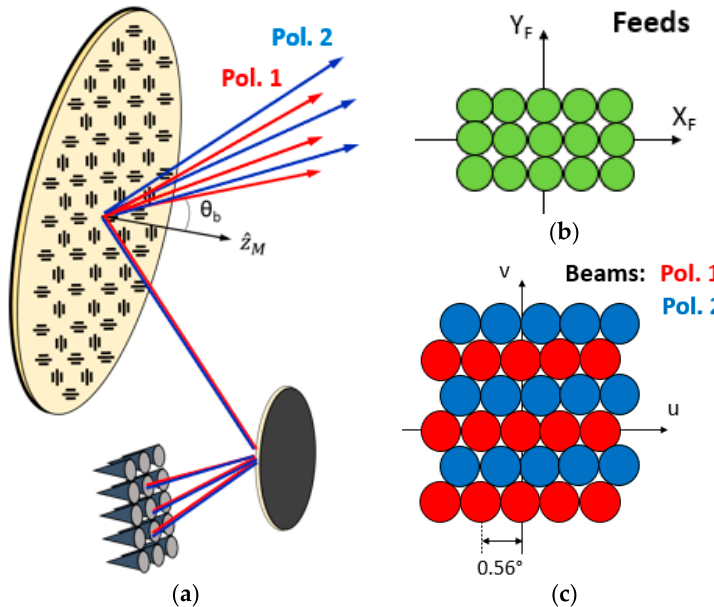
Figure 2. ( a ) Proposed bifocal DRAA configuration with an elliptical main reflectarray (RA) to produce multiple adjacent beams in dual polarization, ( b ) feed cluster and ( c ) beam configuration associated to the proposed antenna to produce a complete multibeam coverage in the